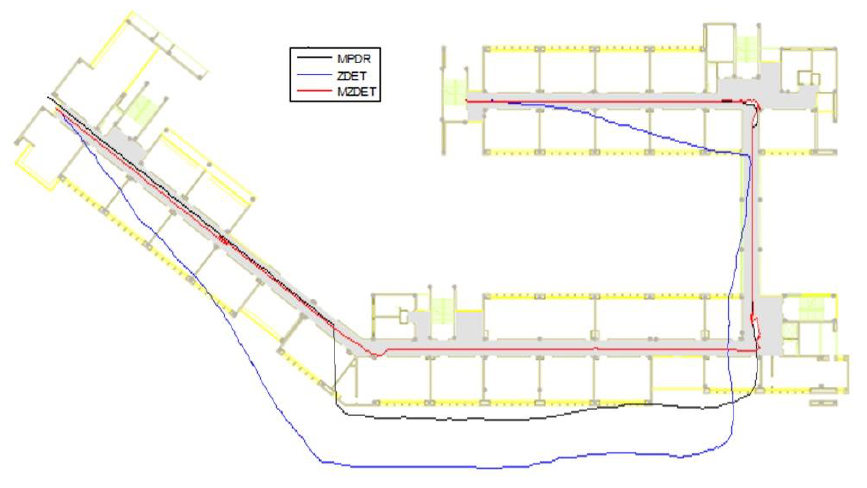
Figure 14 Estimated position of the three schemes.